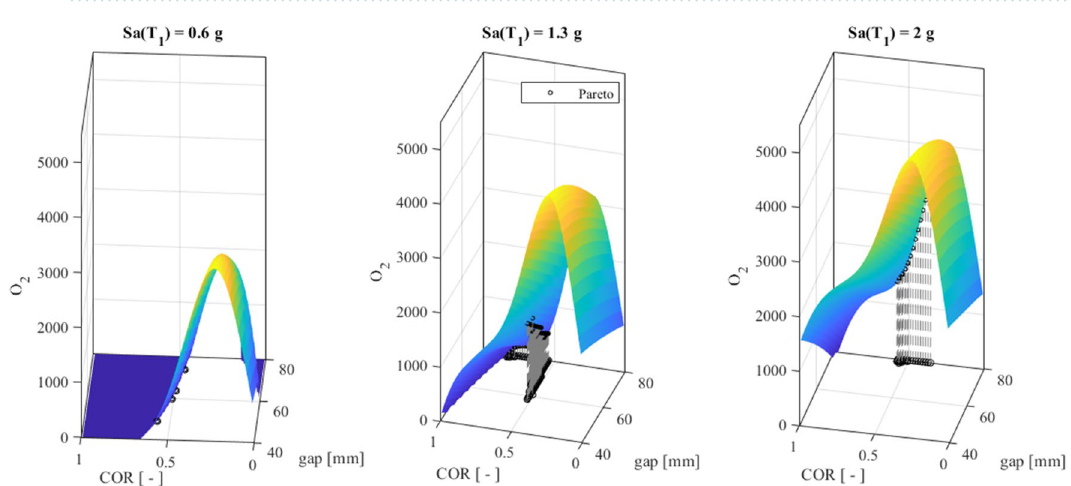
Figure 10. O 1 surfaces for ( a ) the “optimal” Sa(T1) equal to 0.6 g; ( b ) equal to 1.3 g; and ( c ) 2 g.